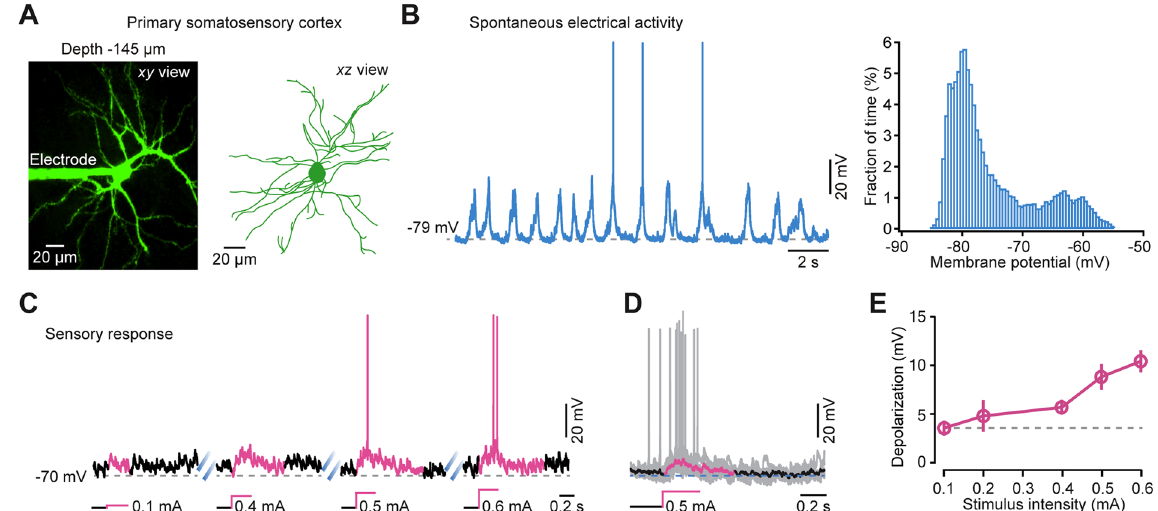
Figure 3. The spontaneous and stimulation-evoked electrical responses in marmoset cortical neurons. ( A ) Z-projection of in vivo two-photon images of a whole-cell patched layer 2 (L2) pyramidal cortical neuron. Left, top view of this neuron. Right, side view of the neuron reconstructed from two-photon images. ( B ) Left, representative whole-cell recording of spontaneous activity from the same L2 neuron as in panel ( A ) under anesthesia. Right, distribution of membrane potentials of this neuron during a 45 s recording period. ( C ) Neuronal responses to different intensities of electrical stimulation of the hind-limb from another neuron . (D ) Overlay of sensory responses to 0.5 mA electrical stimulation from 7 traces. ( E ) Intensity dependence of stimulus-evoked depolarization ( n =